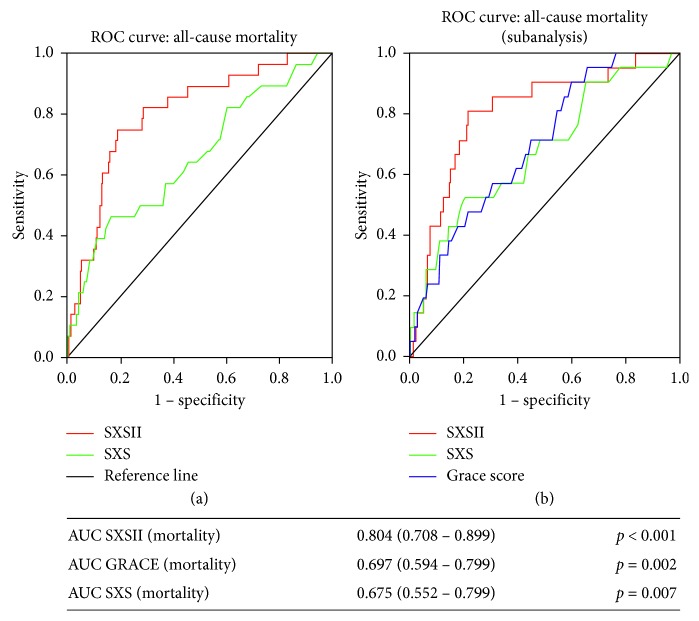
ROC curves. (a) Receiver-operating characteristic (ROC) curves for SYNTAX score II and anatomical SYNTAX in predicting 1-year all-cause mortality (entire population of 734 patients). SxSII (red line) significantly improves prediction over both scores. AUC = area under the curve; CI = confidence intervals. (b) Receiver-operating characteristic (ROC) curves for SYNTAX score II, anatomical SYNTAX, and GRACE risk score in predicting 1-year all-cause mortality (subanalysis of 500 patients).